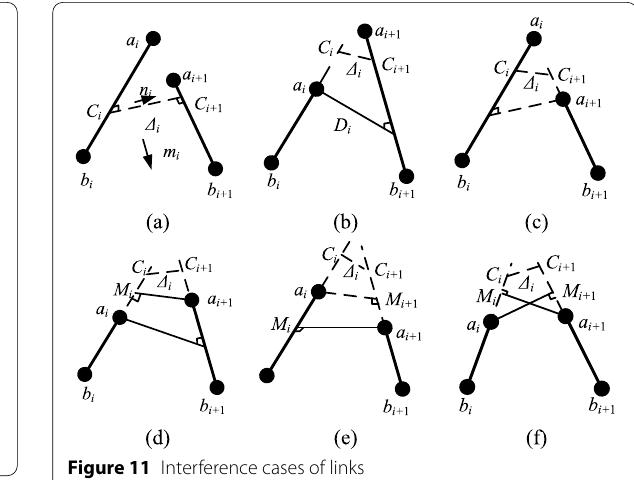
Figure 11 Interference cases of